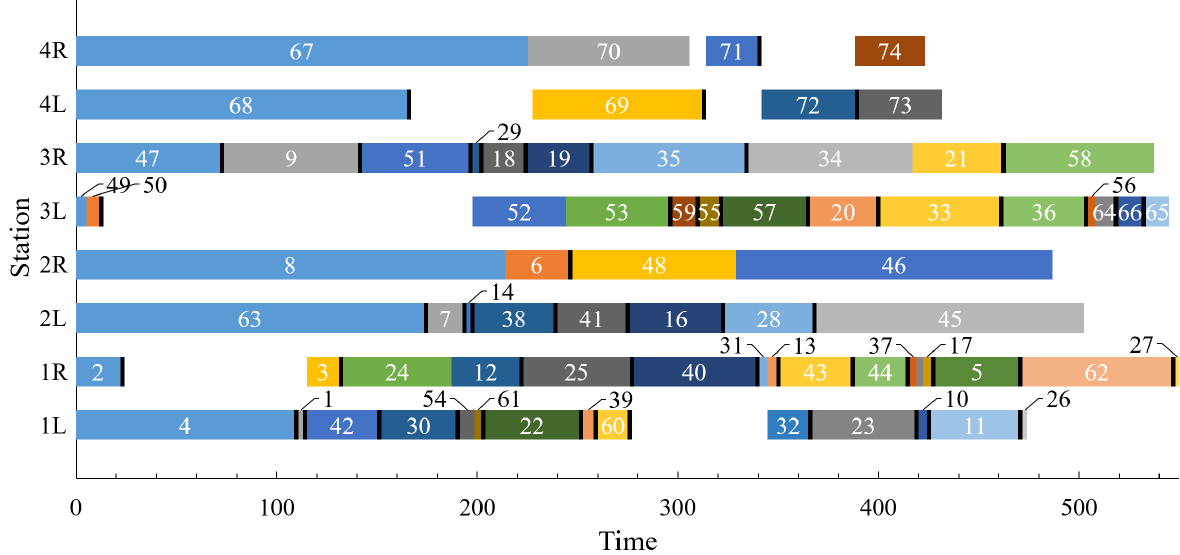
Figure 7. Gantt chart of disassembly scheme S 1 .